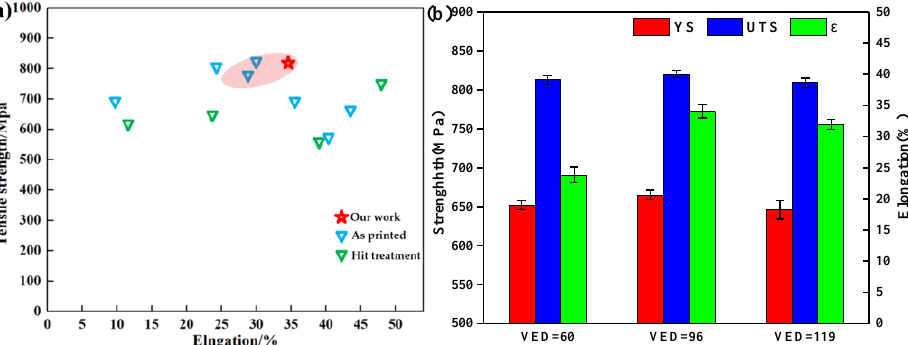
Figure 11. ( a ) A comparison of the strength and elongation of Hastelloy-Xs [13,20,31–33], including our work; ( b ) tensile properties of 60, 96, and 119 J·mm −3 specimens.